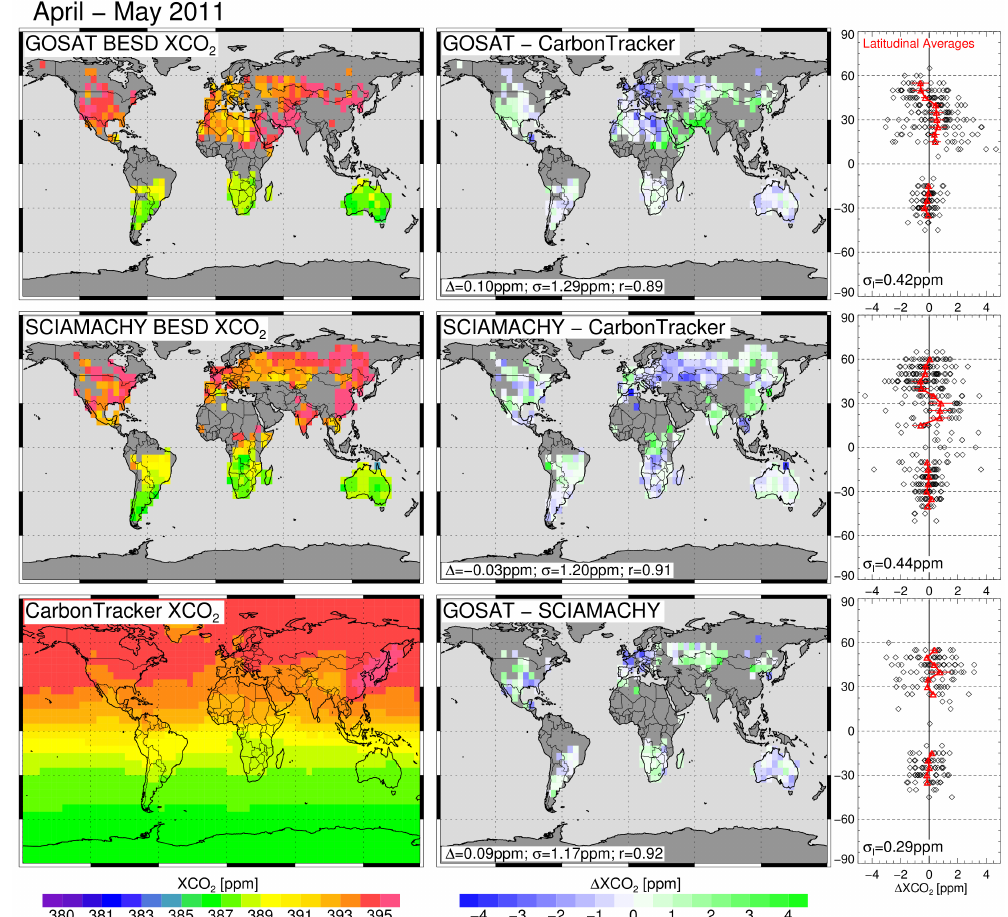
Figure 7. Global maps of XCO 2 (left), XCO 2 differences ( (cid:49) XCO 2 , middle) and latitudinal averages of the differences (right) of GOSAT BESD, SCIAMACHY BESD and CarbonTracker gridded on 5 ◦ × 5 ◦ for April–May 2011. The values shown near the bottom of the difference maps are (cid:49) , the mean difference between the data products, σ , the standard deviation of the difference and r , the correlation coefficient. The black diamonds in the right panels are the XCO 2 differences in the individual grid boxes. The red triangles represent the latitudinal averages and the error bars the latitudinal standard deviation. σ l is the standard deviation over all latitudinal